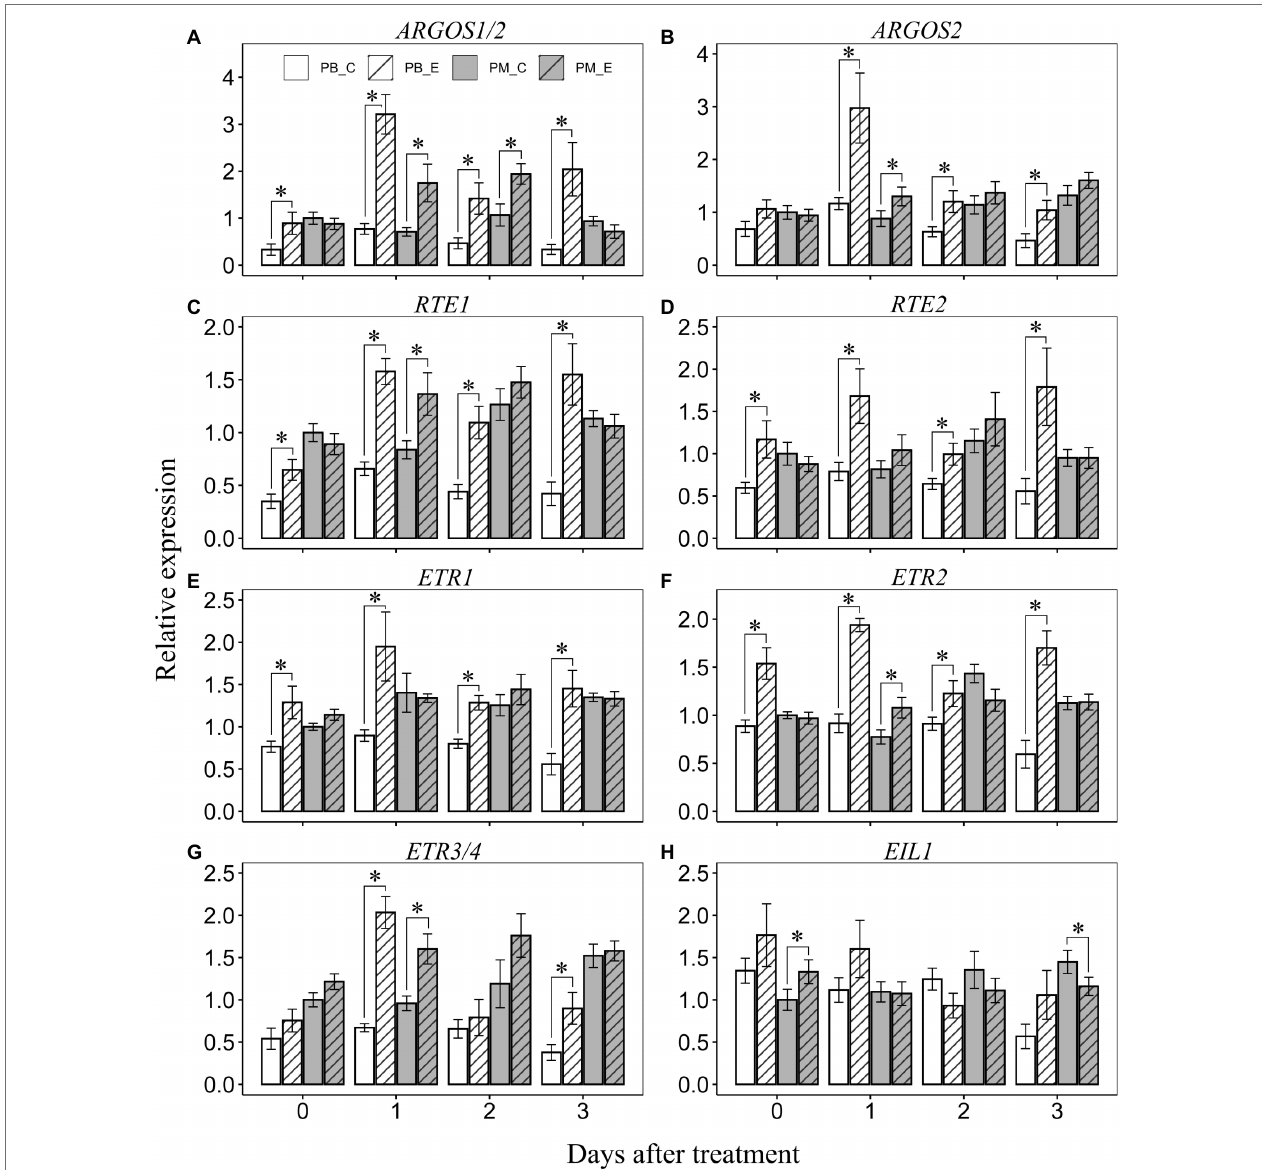
FIGURE 6 | Transcript abundance of ethylene signaling genes after application of ethephon and control at 0, 1, 2, and 3 days after treatment. (A) ARGOS1/2 , (B) ARGOS2 , (C) RTE1 , (D) RTE2 , (E) ETR1 , (F) ETR2 , (G) ETR3/4 , and (H) EIL1. ARGOS , AUXIN REGULATED GENE INVOLVED IN ORGAN SIZE ; RTE , REVERSION TO ETHYLENE SENSITIVITY ; ETR , ETHYLENE RECEPTOR ; and EIL1 , ETHYLENE INSENSITIVE 3–LIKE1 . Asterisk indicates that the means are significantly different between treatments (control and ethephon) within a cultivar and given day according to t -test ( α =